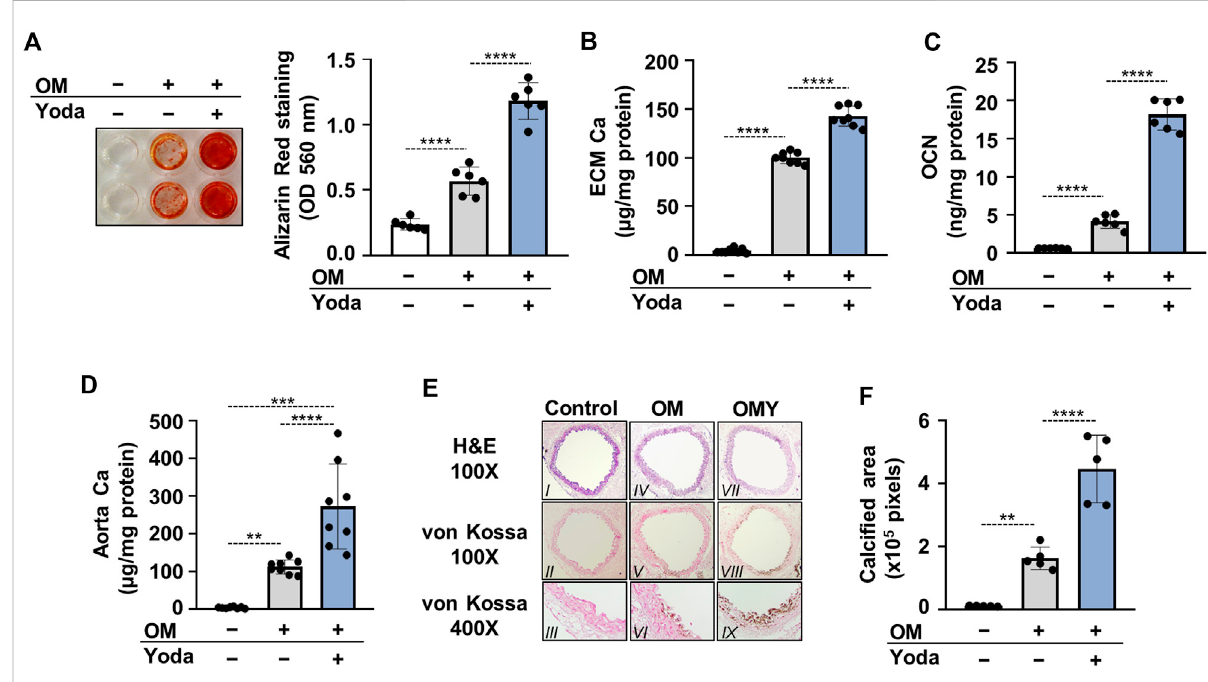
Activation of Piezo1 by Yoda1 increases Pi-mediated osteogenic differentiation and extracellular matrix (ECM) calci fi cation of HAoSMCs and aorta rings. (A – C) HAoSMCs were cultured in osteogenic medium (OM; excess P i : 1.5 mmol/L, excess calcium: 0.6 mmol/L) in the presence or absence of Yoda1 (10 μ mol/L). (A) Representative Alizarin Red staining (day 6) and quanti fi cation. (B) Calcium accumulation in the ECM (day 6). (C) Osteocalcin(OCN)level(day6)inEDTA-solubilizedECMsamples. (D – E) AorticringsobtainedfromC57BL/6micewereculturedincontrol,OM and OM + Yoda1 (OMY) conditions. (D) Calcium content of aorta rings normalized to protein level (day 6). (E – F) Histological analysis of ex vivo cultured aortic rings from C57BL/6 mice. (E) Representative Hematoxylin-eosin (H&E) and von Kossa – stained aortic sections of untreated, OM, and OM+Yoda1-treated(OMY)aortarings(day7).Magni fi cation,×100,×400. (F) Quanti fi cationofvonKossastaining.Dataareshownasmean±SD, n = 3 – 8. * p < 0.05, ** p < 0.01, *** p < 0.005, **** p <